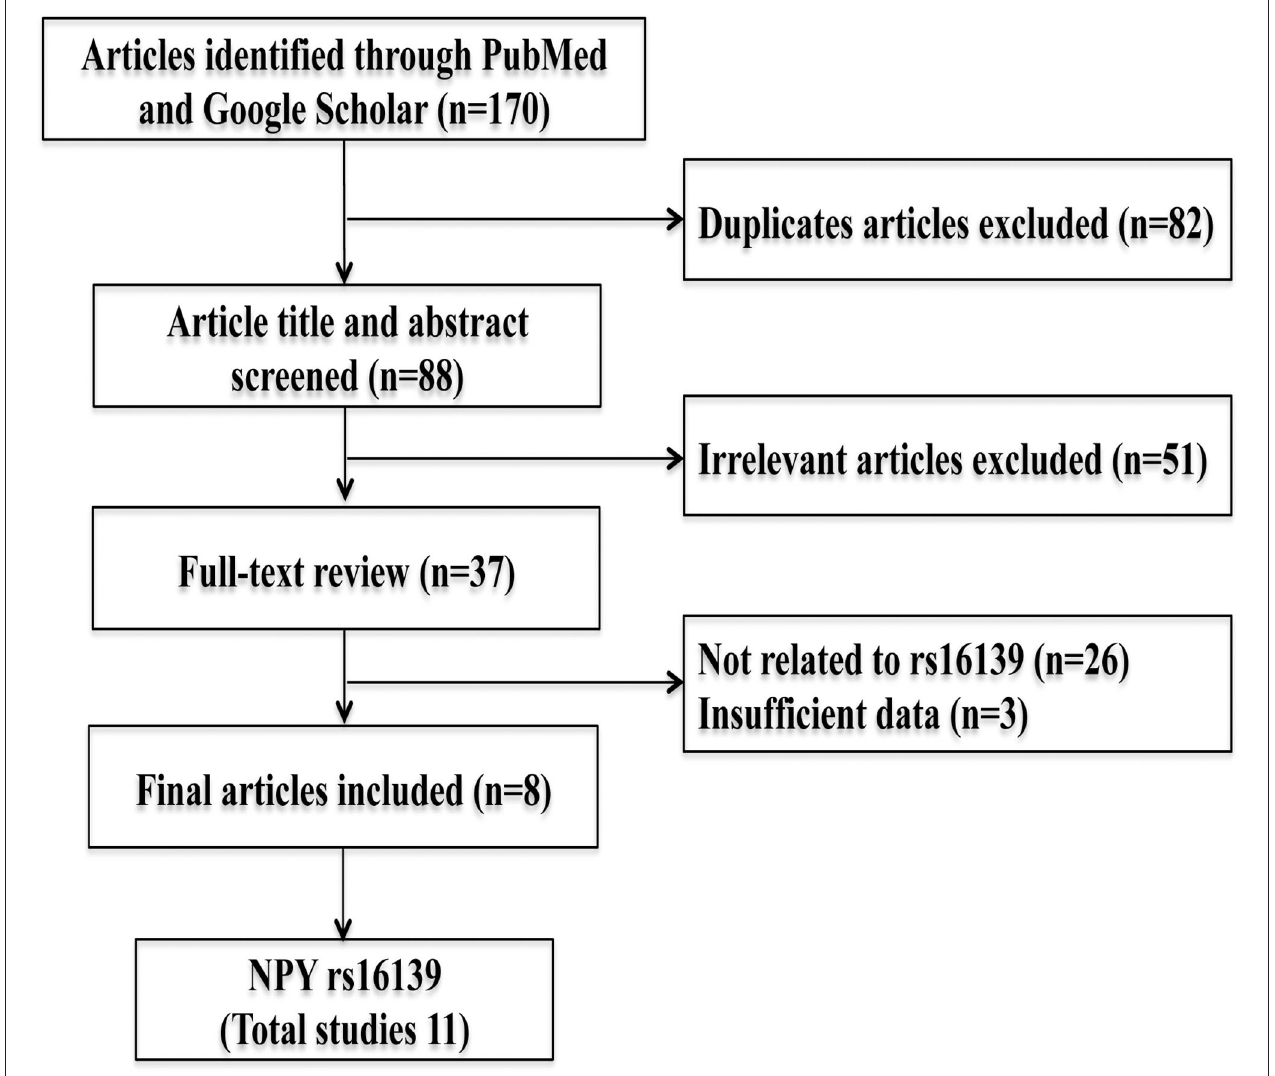
FIGURE 1 | Flowchart depicting the article selection